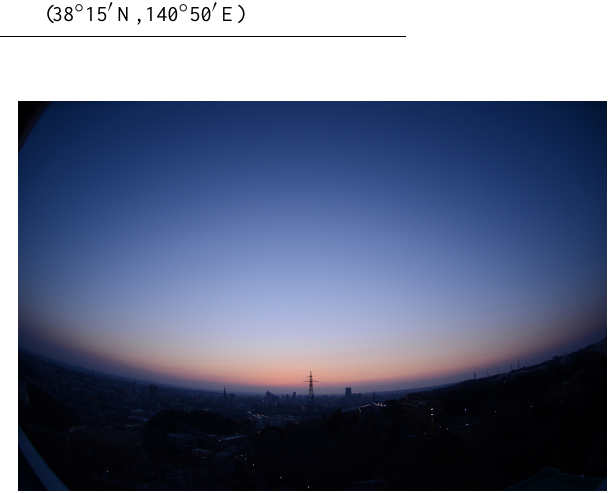
Figure 1. An example of a twilight sky photograph taken on 23 March 2012 in the morning.